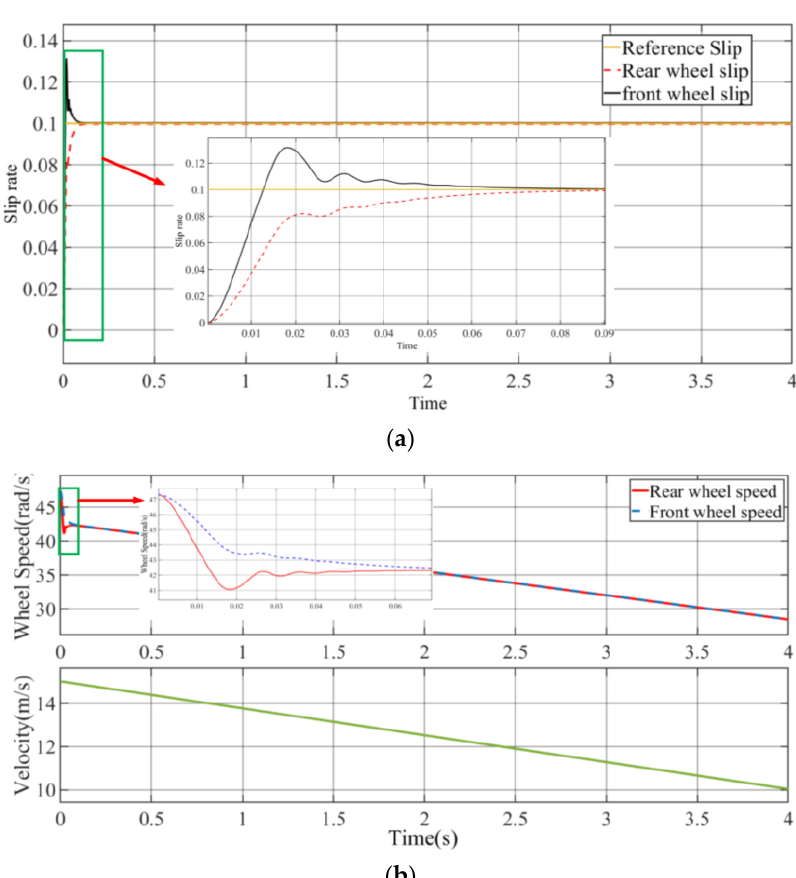
Figure 12. Performance of ordinary regenerative braking mode in hybrid state: ( a ) slip rate variation; ( b ) vehicle speed and wheel speed variation.